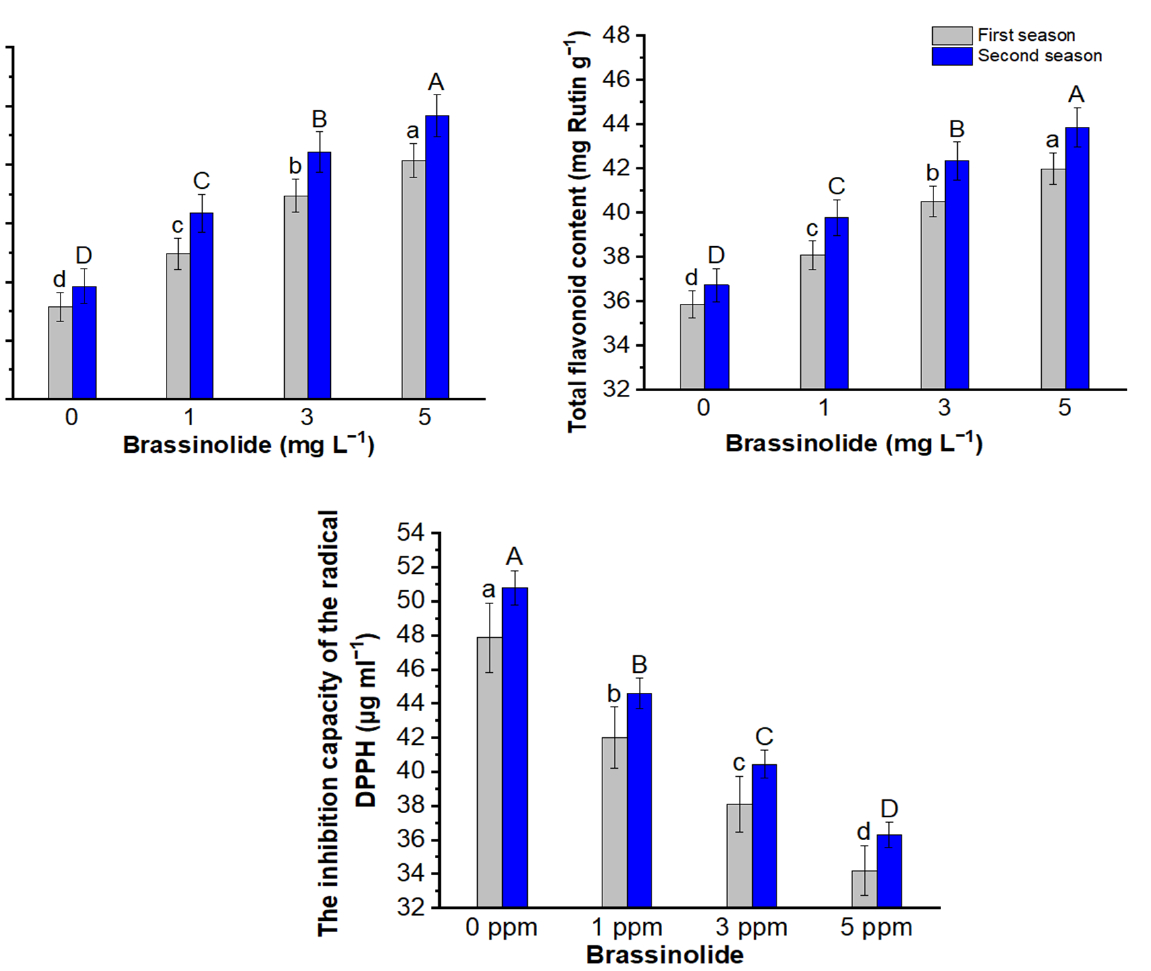
Figure 6. Total phenolic (mg Gallic g − 1 ), flavonoids (mg Rutin g − 1 ), and the inhibition capacity of the radical DPPH ( µ g mL − 1 ) of Opuntia ficus-indica L. plant subjected to brassinolide foliar spray. Data are mean value ± SE. Bars with the same letters (lowercase for the first season and uppercase for the second season) are not significant at p ≤ 0.05 level.